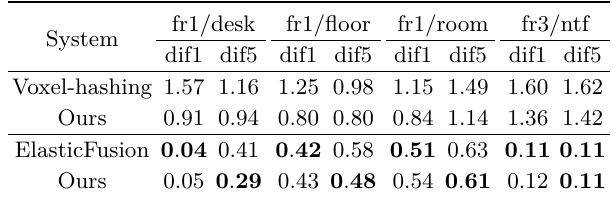
Table 2 Pose estimation comparison of methods using RPE metric System